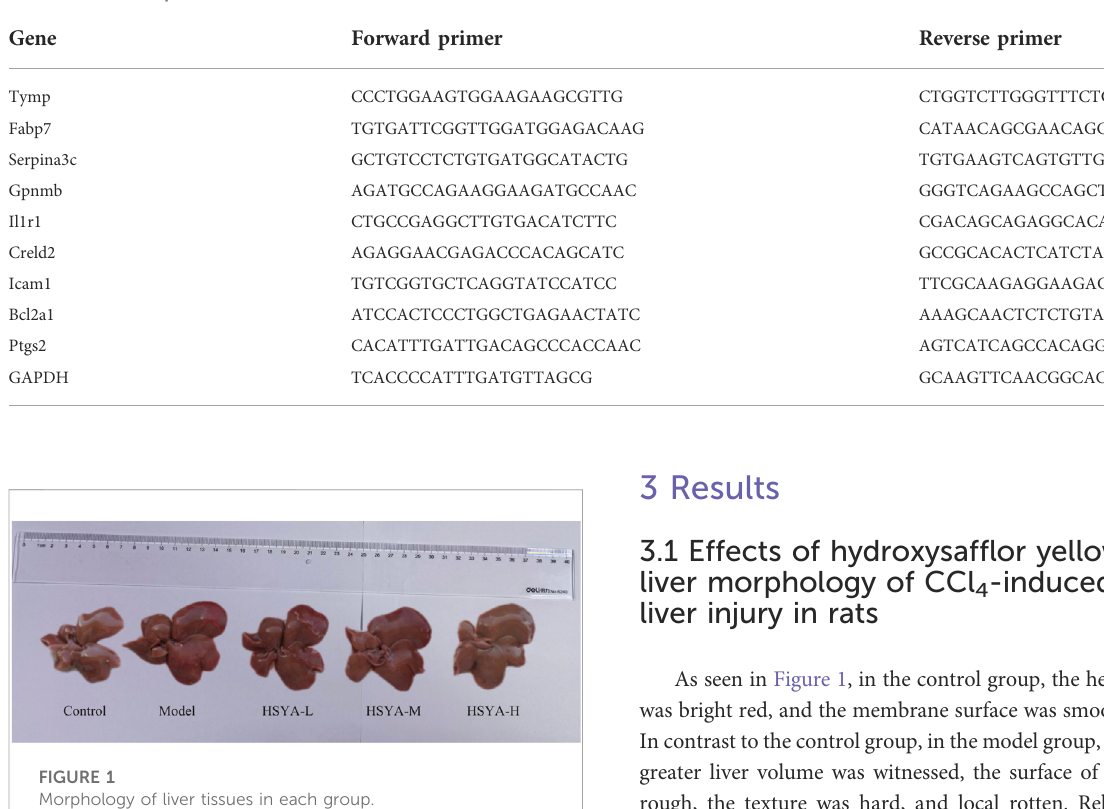
TABLE 1 Primer sequences of DEGs to be measured.